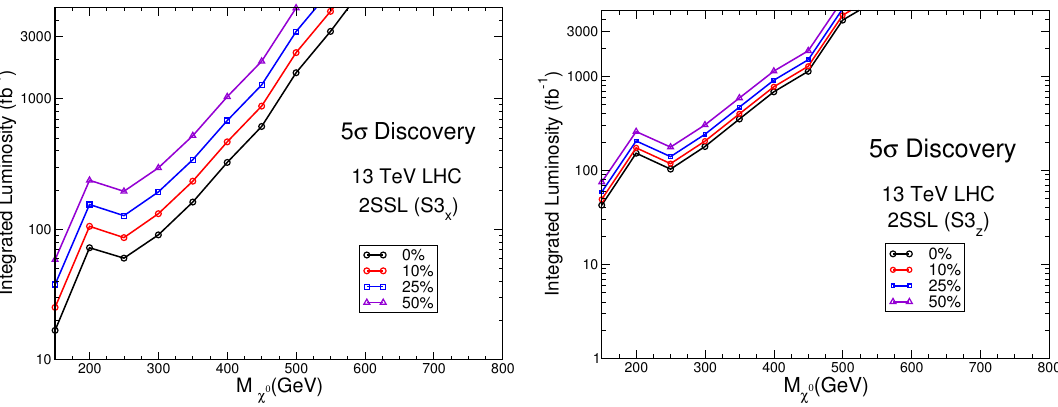
Figure 10 . In the left panel, we show the required integrated luminosity for 5 (cid:27) discovery ( Z dis 5) after imposing the S 3 x selection criteria in the 2SSL channel at the 13 TeV LHC as a function of M . The right panel depicts the same for selection criteria S 3 z . The colored lines in both the (cid:31) 0 panels are for the di(cid:11)erent level of uncertainties in the background events ranging from 0 to 50%. integrated luminosity, one can exclude up to 610 GeV of the neutral state mass ( M selection S 3 is applied. Also from (cid:12)gure 10, we can say that after selection S 3 x 3000 fb (cid:0) 1 integrated luminosity, the discovery prospects will be challenging if the neutral state mass is greater than 475